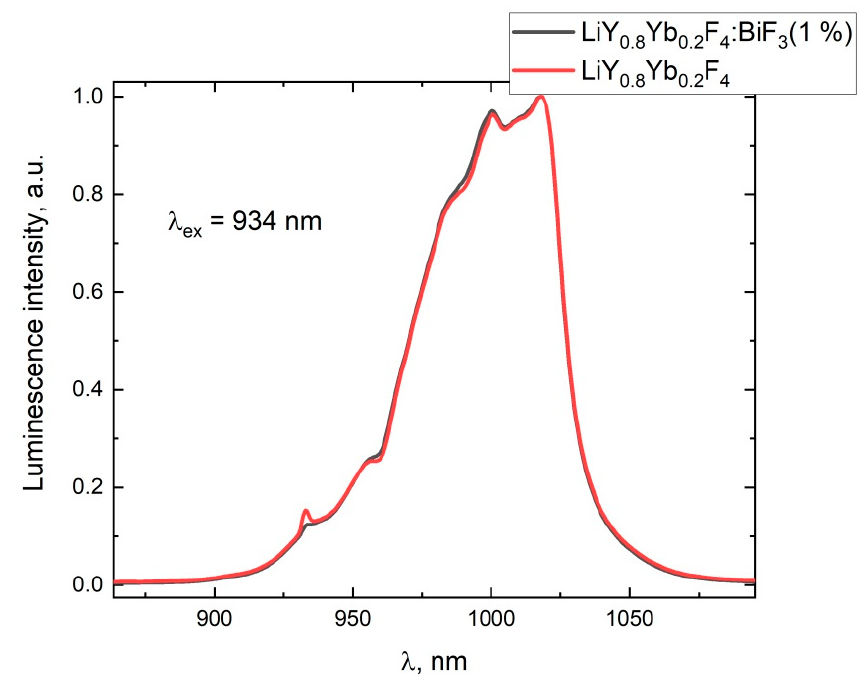
Figure 3. The normalized luminescence-spectra of the LiY 0.8 Yb 0.2 and LiY 0.8 Yb 0.2 :BiF 3 (1%) samples under 934 nm laser-excitation.